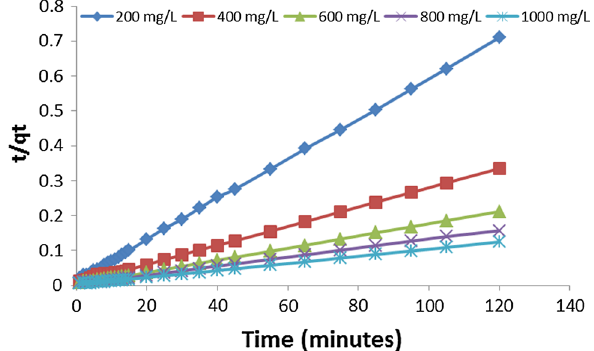
Table 7 Comparison of adsorption capacities of Rh-B dye with